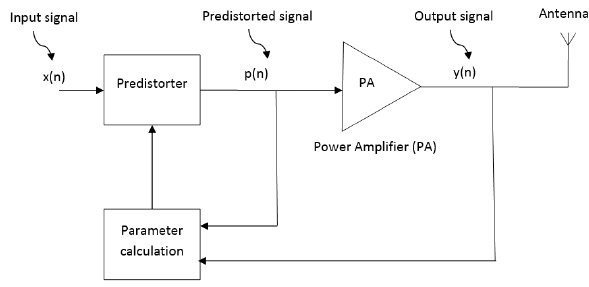
Figure 3. Generic predistortion scheme.